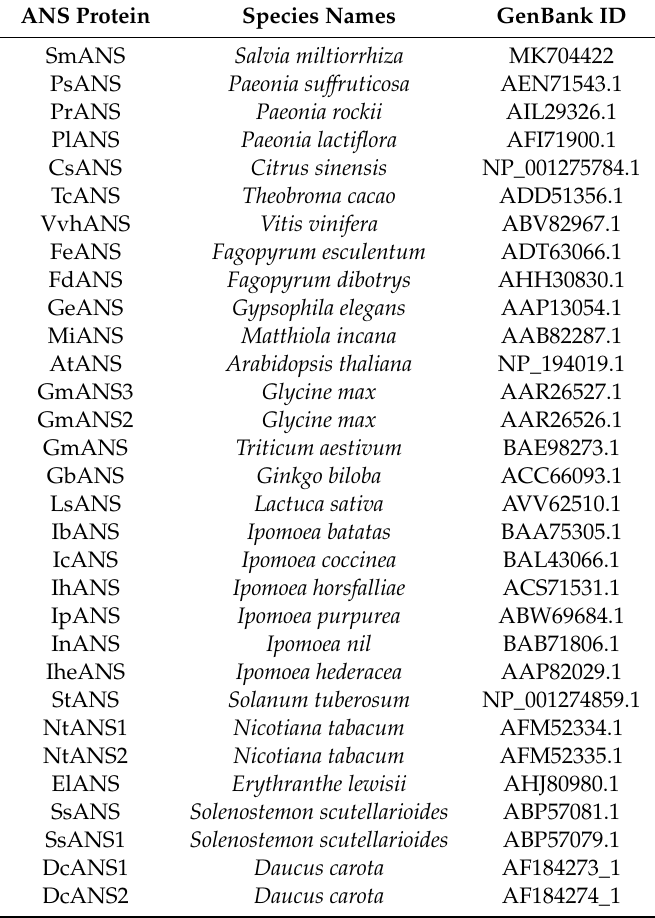
Table A2. The ANS protein sequence for constructing phylogenetic